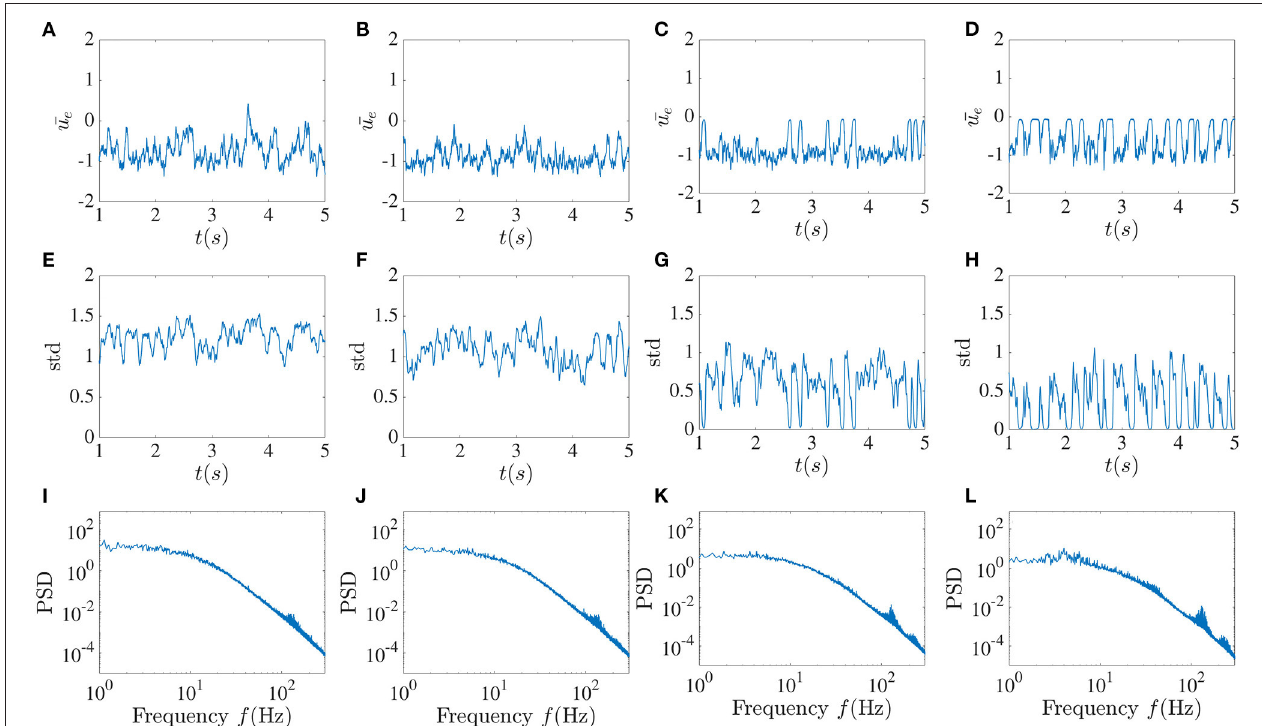
FIGURE 5 | Higher global feedback strength causes activity dropouts. Mean (A–D) and standard deviation (E–H) of the excitatory sub-network activities, with the corresponding mean power spectrum (I–L) in the presence of global inhibitory feedback without noise. From left to right the global feedback strength κ equals 2, 4, and 6 and in all cases, the global feedback time delay is T − − − between dropouts the standard deviation increases.